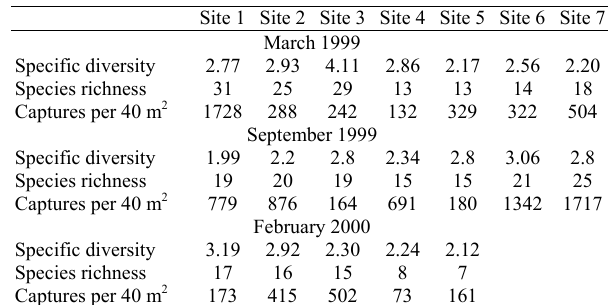
Table 3. Variation in the fish assemblage attributes in the studied sites during different hydrologic conditions.